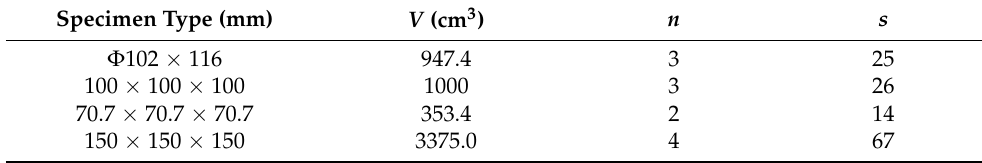
Table 4. Light compaction method operating